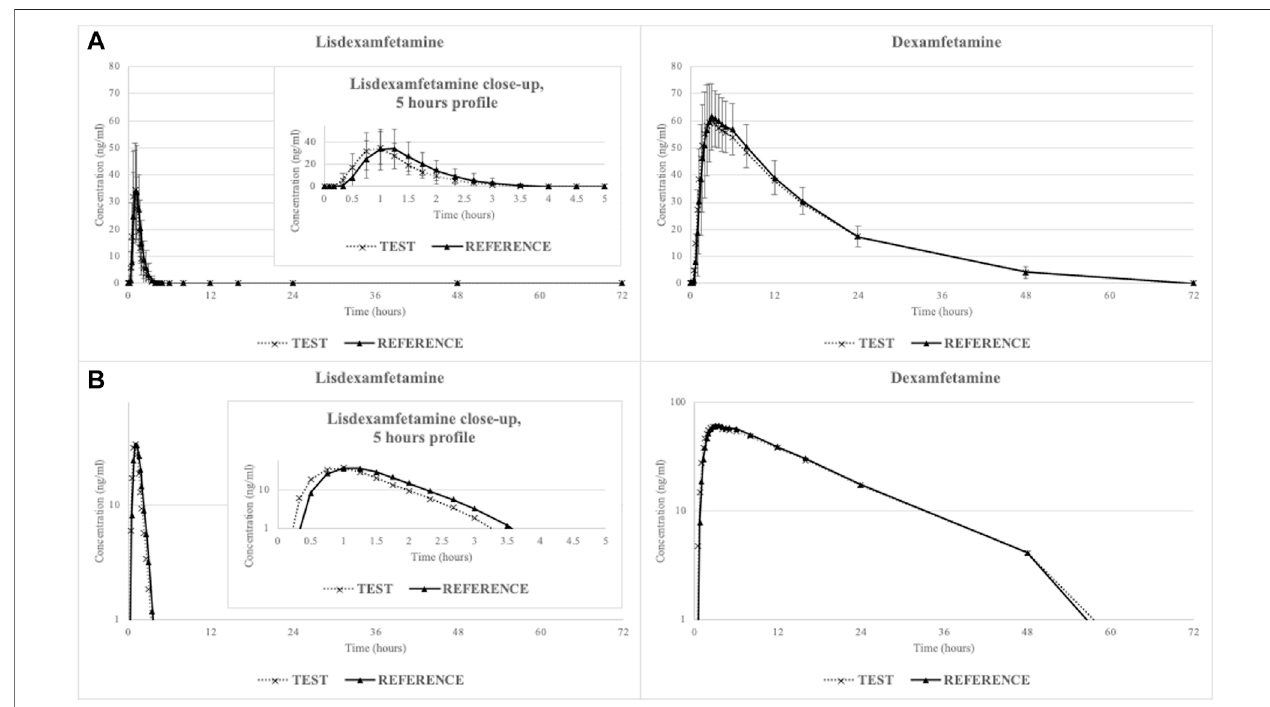
FIGURE 1 | Mean lisdexamfetamine and dexamfetamine concentration-time curves (N = 29) in linear-linear display (A) and ln-linear display (B) .